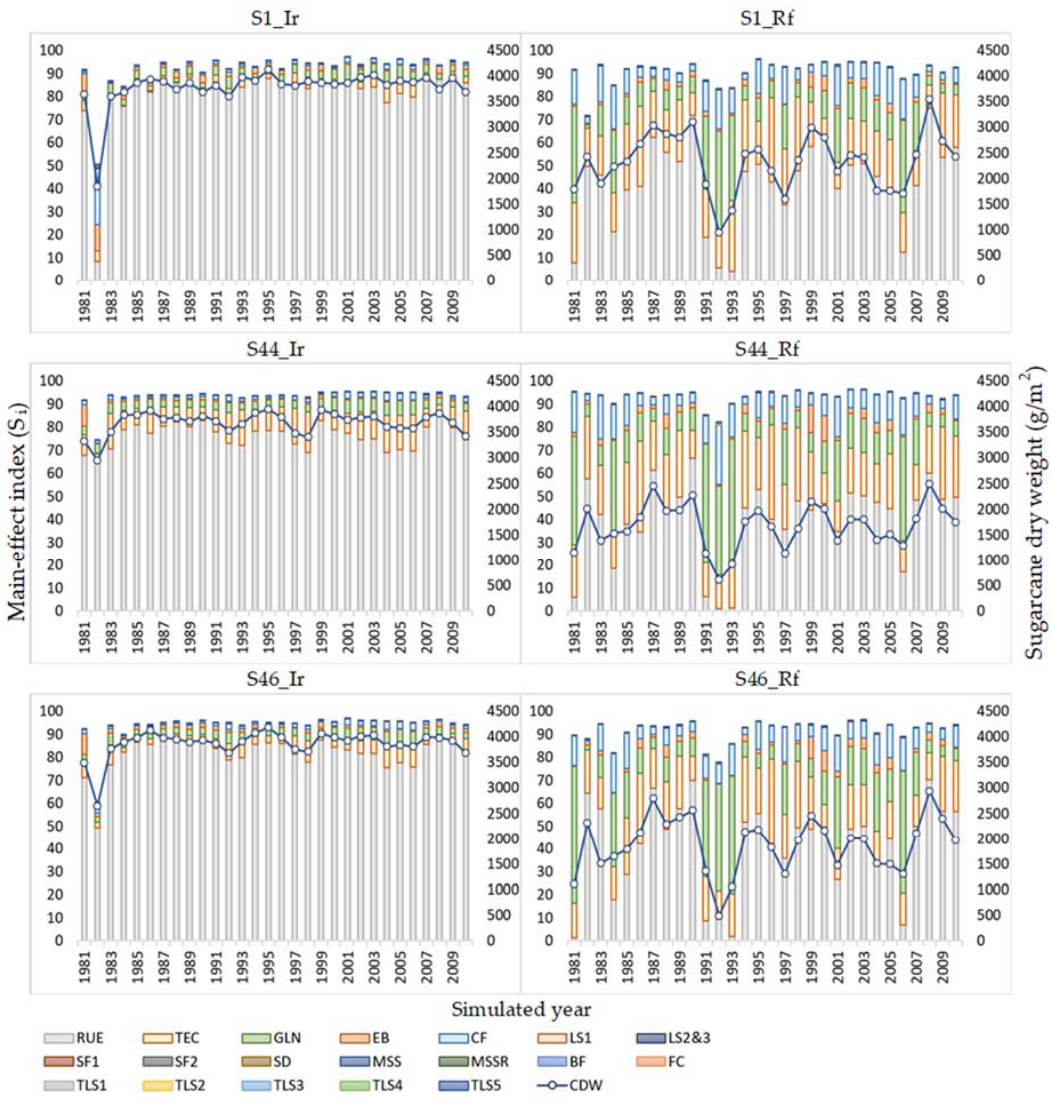
Figure 4. Parameter S i values and CDW of soil type S1, S44 and S46, under Ir and Rf conditions across 30 simulated years from 1980–2010.